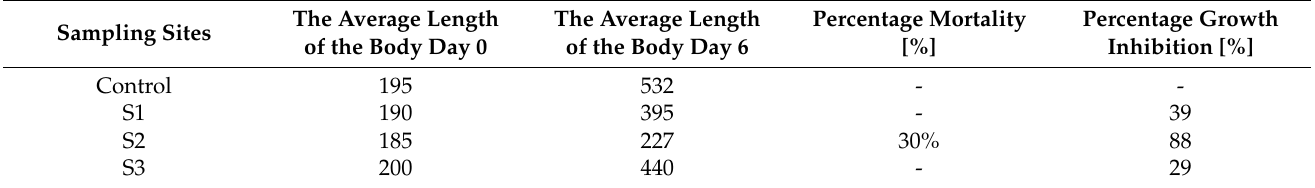
Table 5. The percentage of mortality via Ostracodtoxkit F for the studied sediments from sites S1 “Bł˛ekitna Laguna”, S2 “Huta”, and S3 “Mała Szwecja”